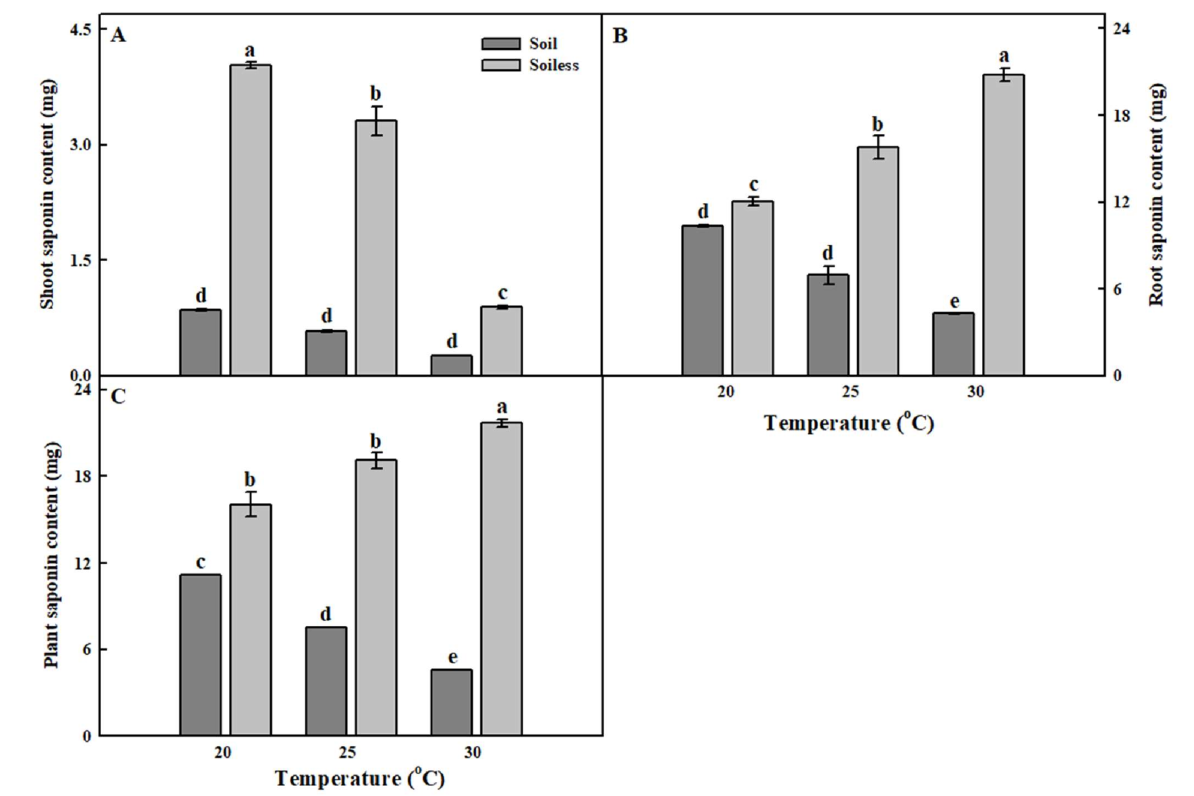
Figure 3. The saponin contents of shoot ( A ), root ( B ), and plant ( C ) of balloon flower sprouts grown under soil culture and soilless culture systems with different temperatures at 17 days after transplanting. Different letters indicate significant difference at p < 0.05 ( n =